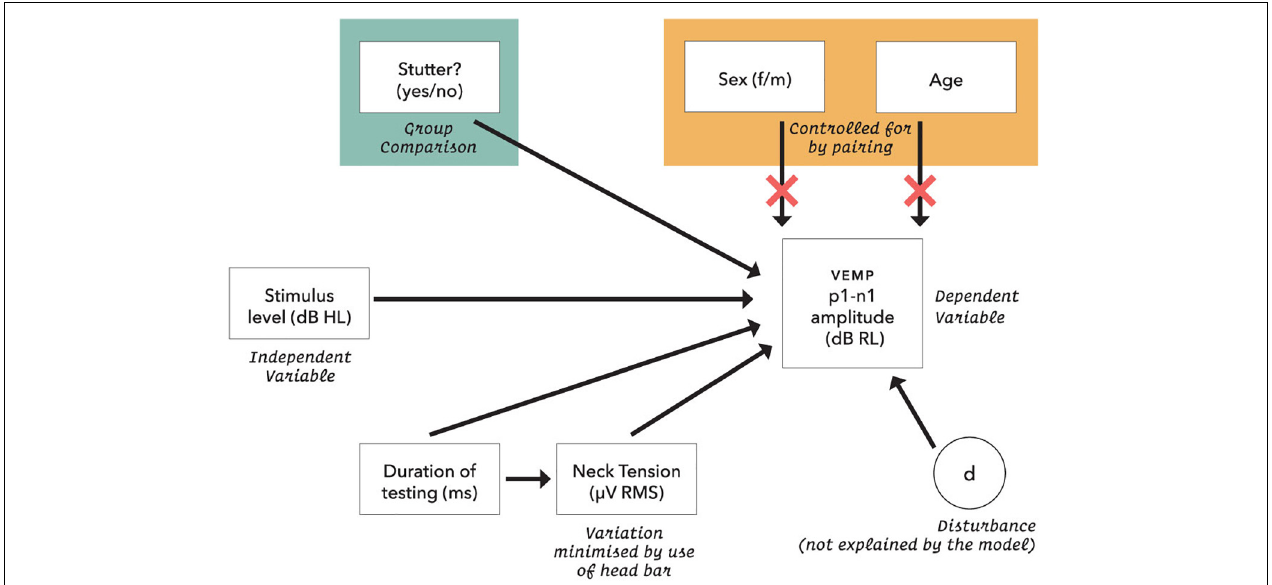
FIGURE 5 | Initial statistical model for VEMP p1-n1 response amplitude. Neck tension was a root mean square of the pre-stimulus VEMP p1-n1 amplitude based on each presentation sequence of 300 stimulus repetitions. Age was calculated in days at the time of testing. The dB RL units used for vestibular response are a log transformation of the VEMP p1-n1 amplitude, such that zero dB RL corresponds to vestibular threshold (although, see note in Figure 11 ). Possible disturbances include neck size, pulse rate and crossed response.